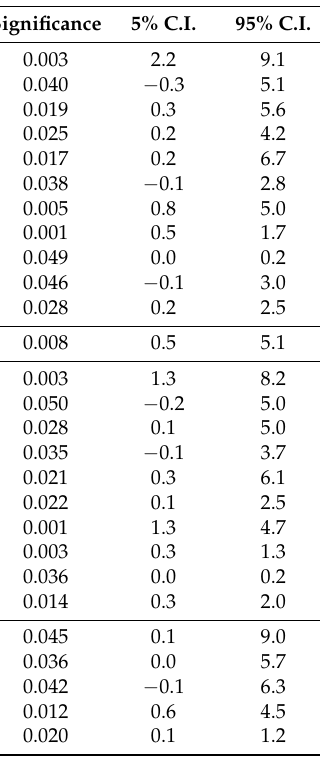
Table 5. Same as in Table 4 except the control is a one-week lag.